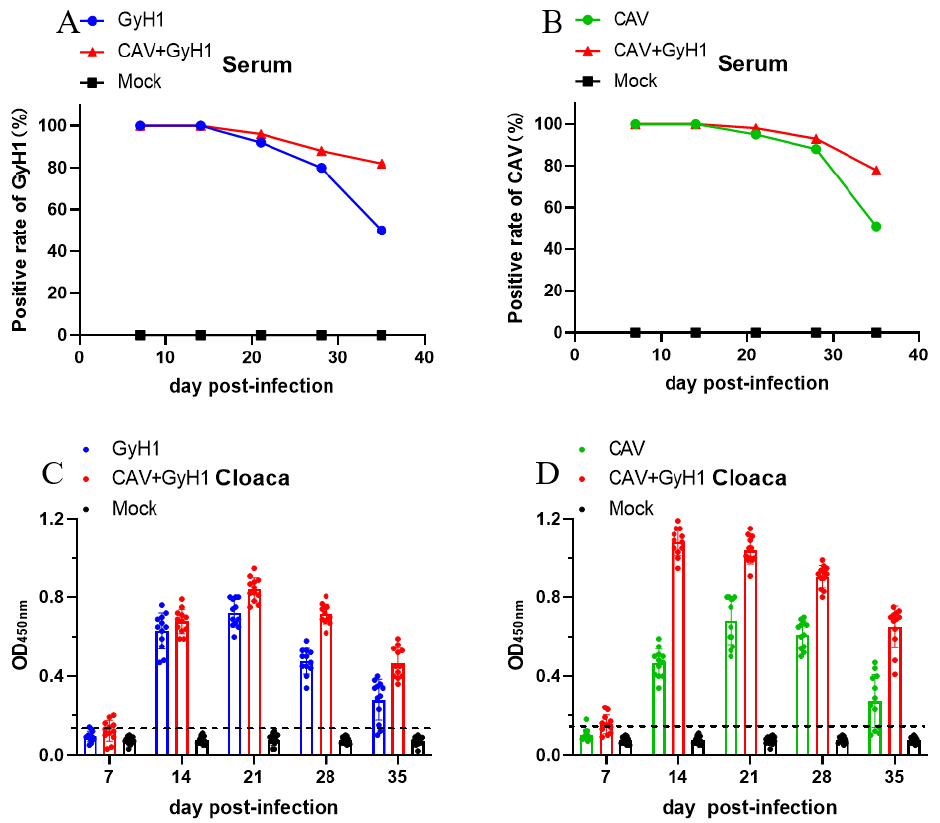
Figure 2. Dynamic changes of positive viremia rate and virus shedding. ( A ) Comparison of the GyH1 viral positive rates in serum in Mock, GyH1, and co-infected chickens at different time points, determined by DAS-ELISA. ( B ) Comparison of the CAV viral positive rates in serum from chickens in Mock, CAV, and co-infected chickens at different time points, determined by ELISA. ( C ) Comparison of VP1 antigen levels of GyH1 in cloacal swabs in Mock, GyH1, and co-infected chickens at different time-points, determined by DAS-ELISA. ( D ) Comparison of VP1 antigen levels of CAV in cloacal swab Mock, GyH1, and co-infected chickens at different time-points, determined by ELISA.